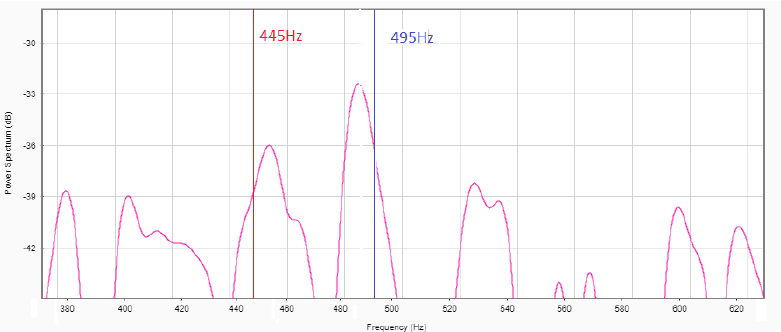
Figure 16. Frequency response of the harvester.